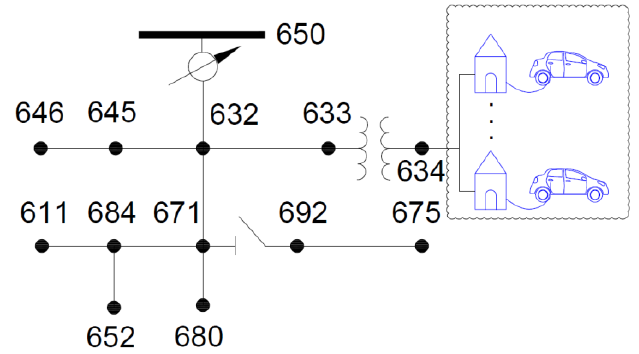
Figure 8. IEEE 13 distribution node test feeder with homes and EVs.